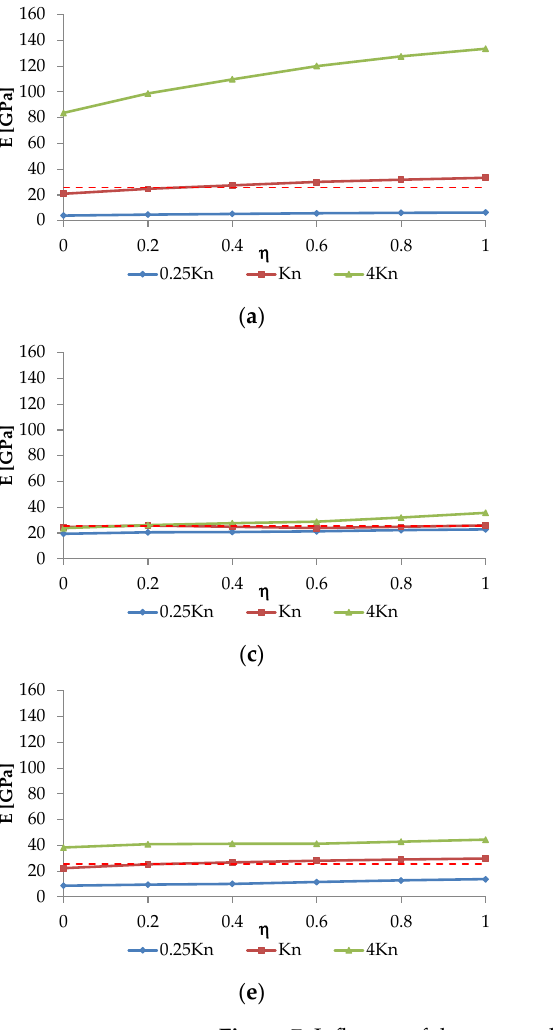
Figure 7. Influence of the contact deformability parameters (K n and η ) on the elastic macroscopic properties of the particle assembly ( E and υ ) for the rigid contact PM model [14] and for the proposed flexible FEM PM model for two different finite element Young´s modulus values: ( a ) Rigid PM model [14]: Macroscopic Young’s modulus for varying η n = 1.08 × 10 4 GPa/m; ( b ) Rigid PM model [14]: Macroscopic Poisson’s coefficient for varying η -K n = 1.08 × 10 4 GPa/; ( c ) Flexible PM model: Macroscopic Young’s modulus for varying η -K n = 18.00 × 10 4 GPa/m, E = 25.8 GPa; ( d ) Flexible PM model: Macroscopic Poisson’s coefficient for varying η -K n = 18.00 × 10 4 GPa/m, E = 25.8 GPa; ( e ) Flexi- ble PM model: Macroscopic Young’s modulus for varying η -K n = 2.06 × 10 4 GPa/m, E = 51.6 GPa; ( f ) Flexible PM model: Macroscopic Poisson’s coefficient for varying η -K n = 2.06 × 10 4 GPa/m, E = 51.6